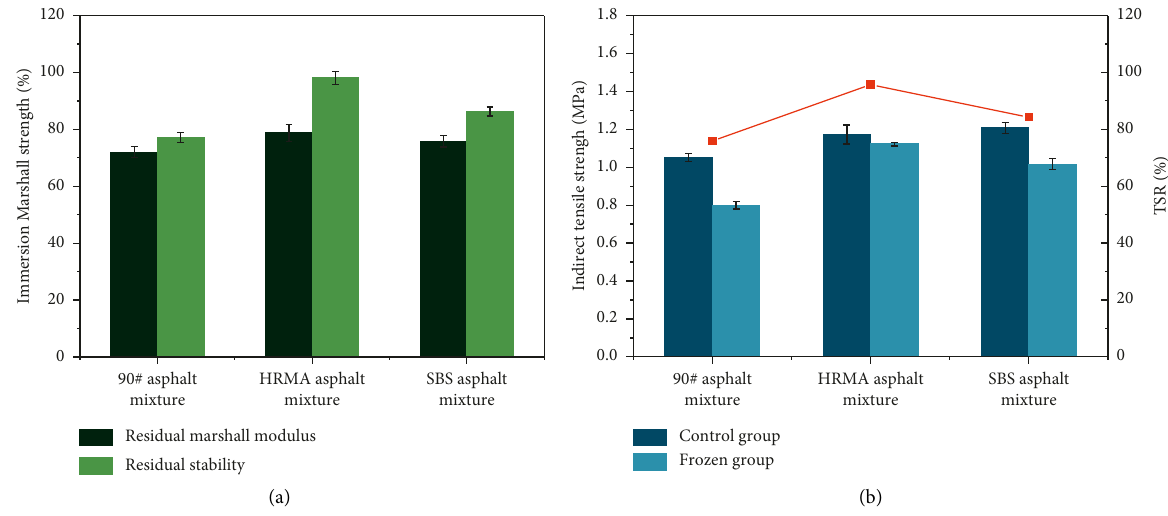
Figure 15: Antiwater damage ability of asphalt mixtures: (a) immersion Marshall test; (b) freeze-thaw splitting